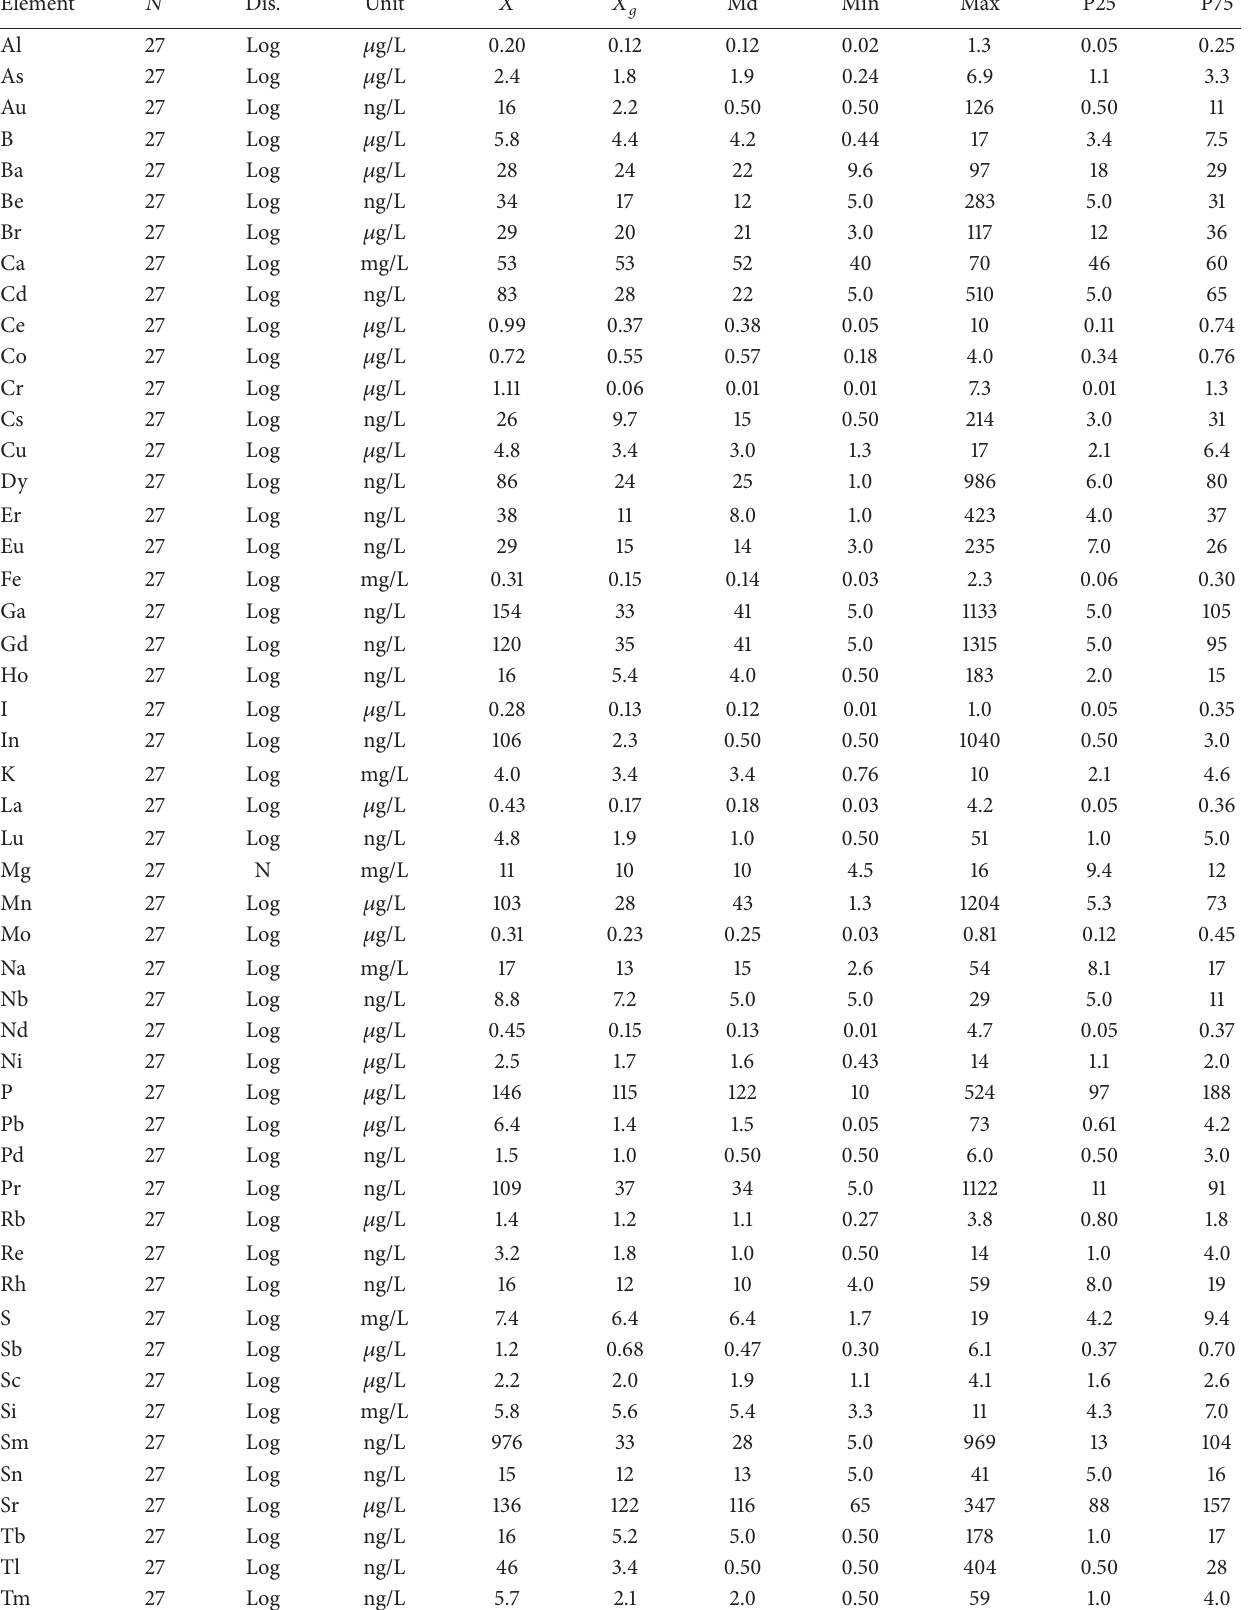
Table 2: Descriptive statistics of chemical analysis of river water from Vardar and its